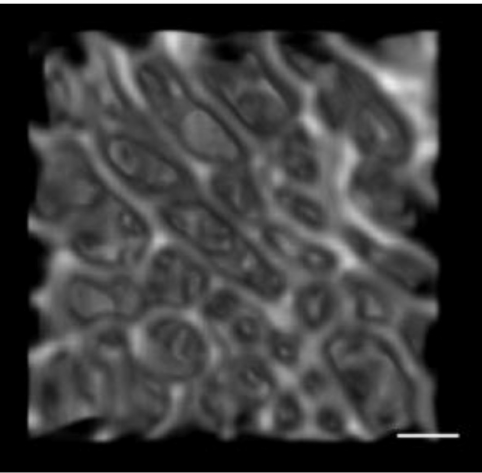
Figure 1. Proximal tibia VOI placements. Note: Left image—lateral condyle, transverse view; center image—medial condyle, transverse view; A—anterior; P—posterior; 1–4—VOIs within condyle; 5–7—intercondylar VOIs; right image—coronal view.